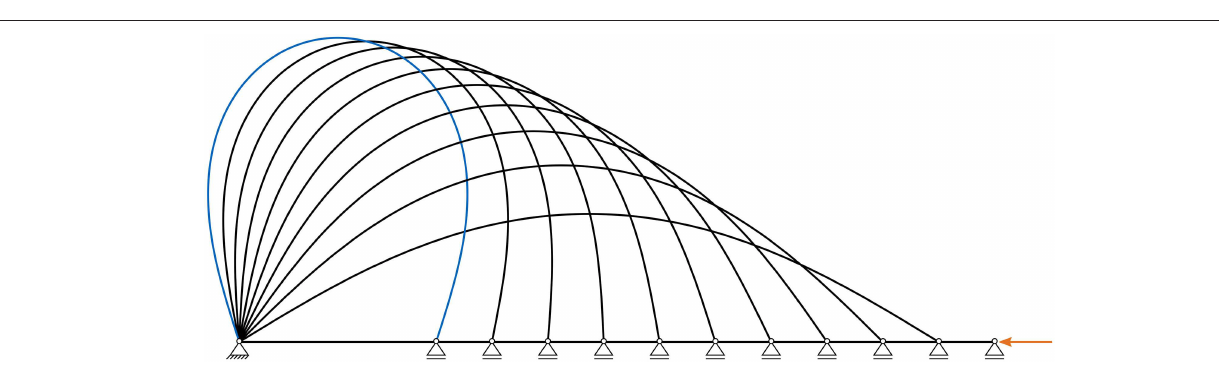
FIGURE 4 | The principle of active bending by deforming an initially straight element into a curved one.